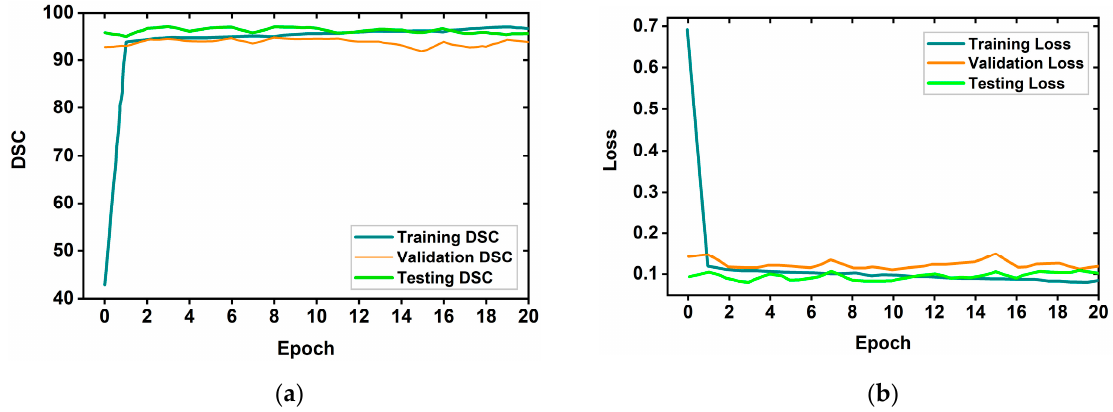
Figure 12. The training results graph: ( a ) the DSC graph; ( b ) loss graph.